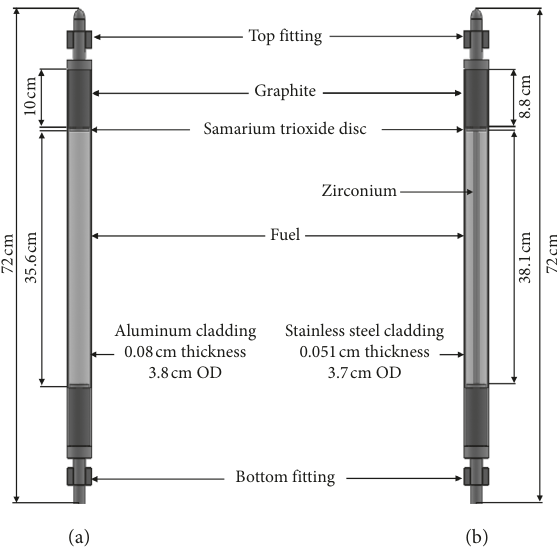
Figure 2: (a) Aluminum and (b) stainless steel cladded fuel elements of the